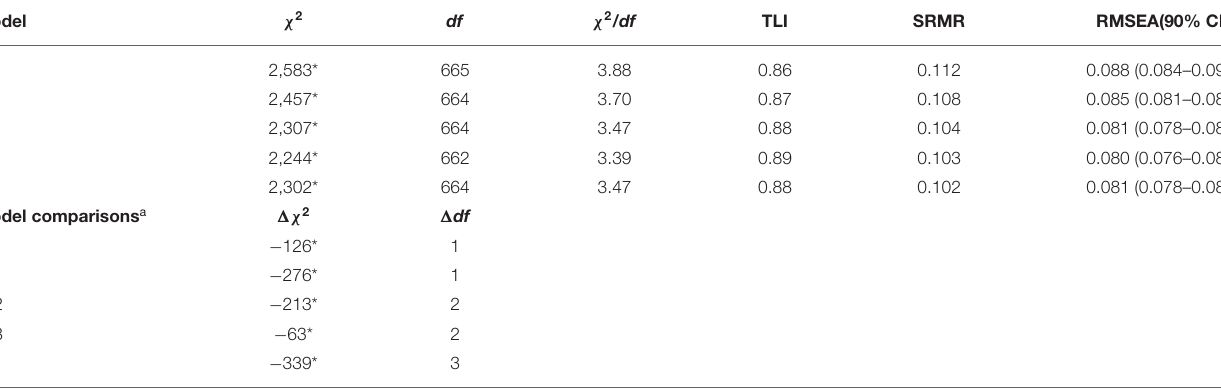
TABLE 2 | Model fit estimates from confirmatory factor analyses of five theoretical models of burnout, compassion fatigue, and secondary traumatic stress.